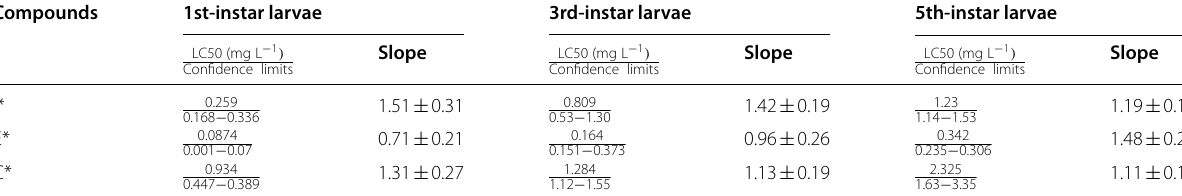
E*: Emamectin benzoate, I*: Indoxacarb, C*: Chlorantraniliprole Table 3 Effect of tested formulations on mortality and weight gain of two larval instars of A. ipsilon